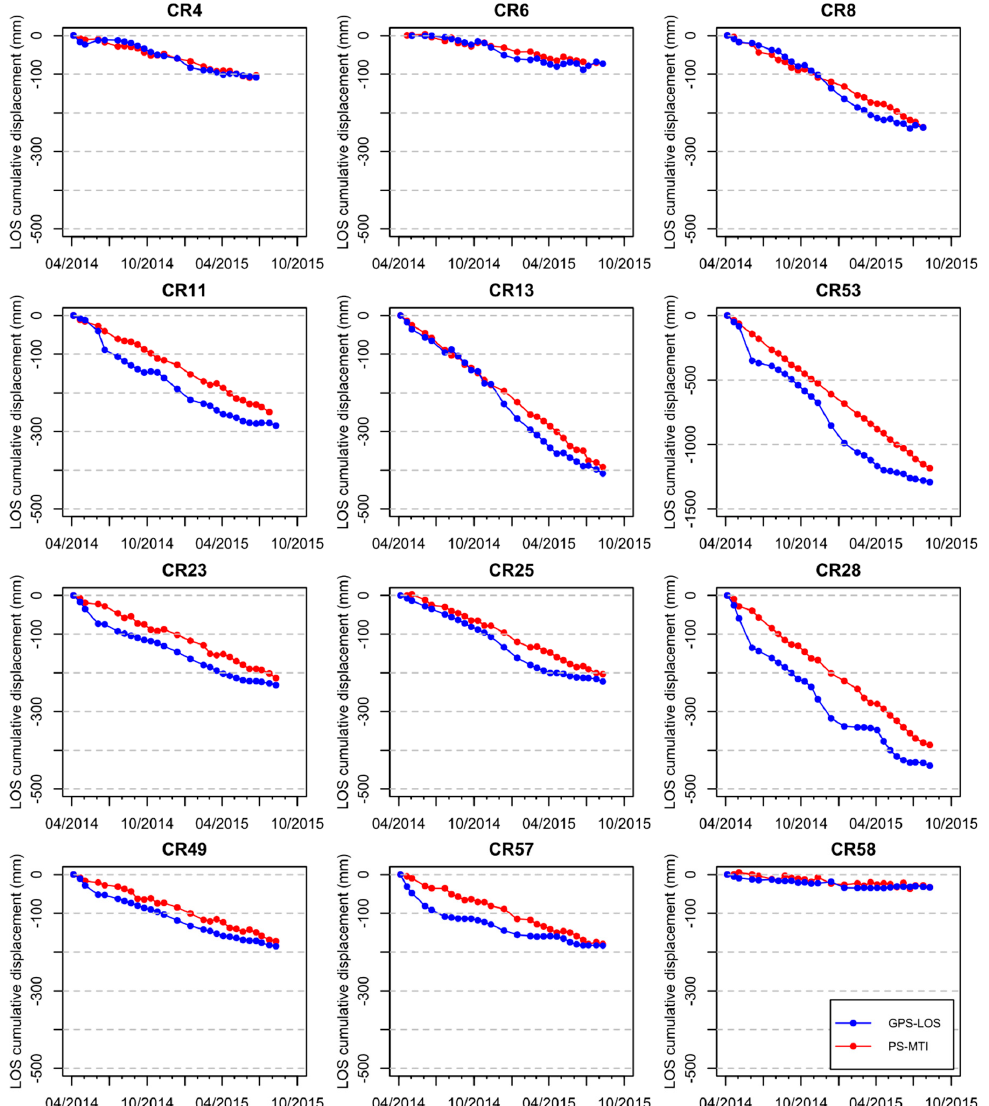
Figure 5. Cumulative displacements retrieved by PS-MTI (red) compared with GPS validation surveys (blue): CR4; CR6 CR8 and CR11 are part of the track zone; CR13 and CR53 are part of the transit zone; and CR23, CR25, CR28, CR49, CR57 and CR58 characterize the depletion zone. Note that, due to the large displacements recorded, the diagram of CR53 is out of scale respect to the others.